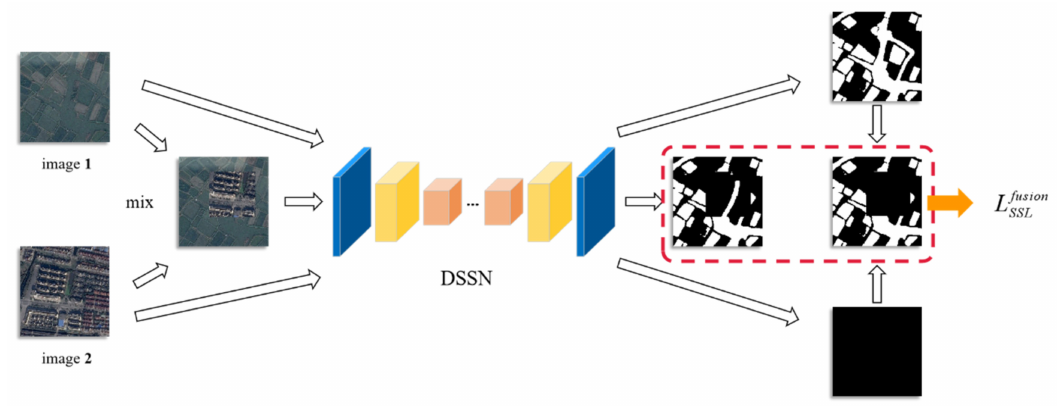
Figure 4. The structure of image context fusion